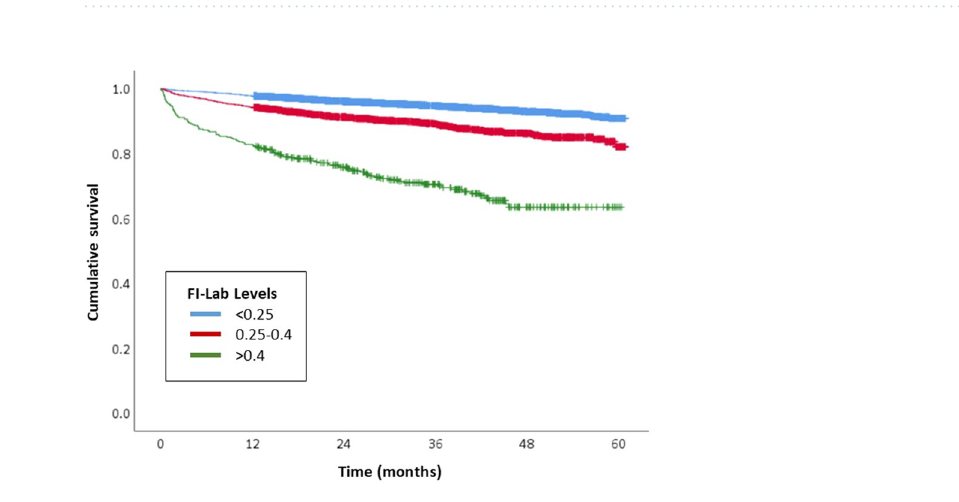
Figure 2. Kaplan–Meier survival curves among older surgical patients with cancer separated by frailty